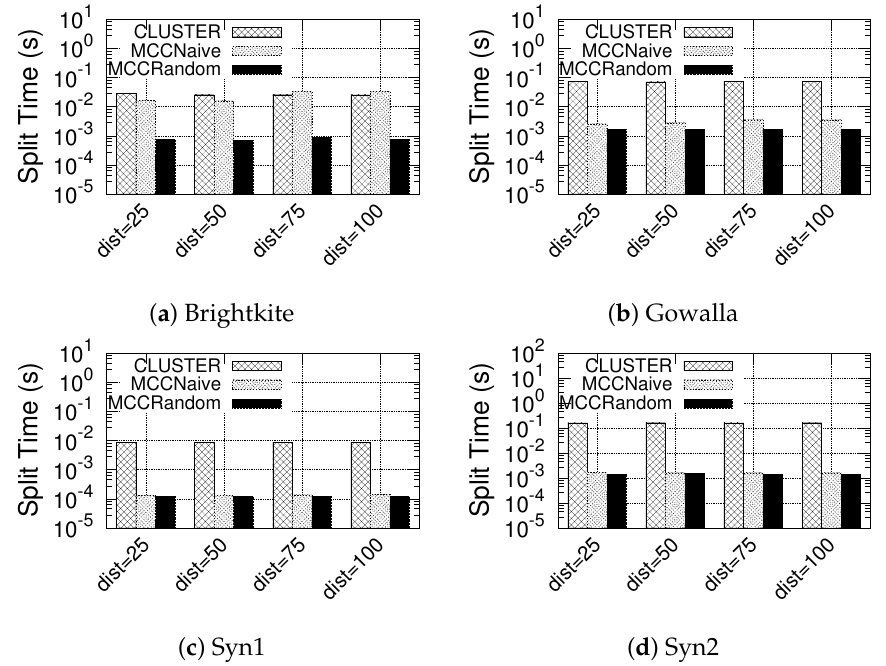
Figure 6. (Eval-II) Split time of clustering and MCC computation.